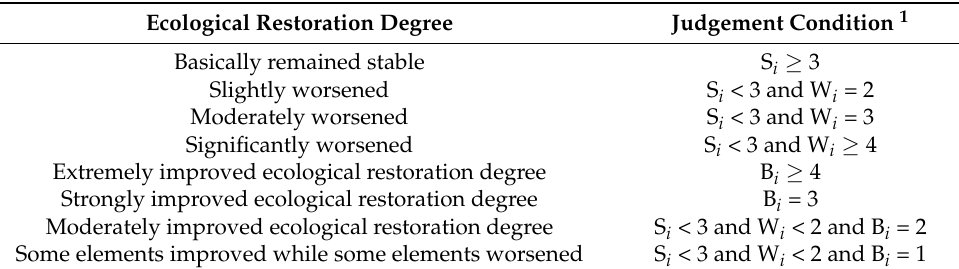
Table 3. Basis for judging the ecological restoration degree. Ecological Restoration